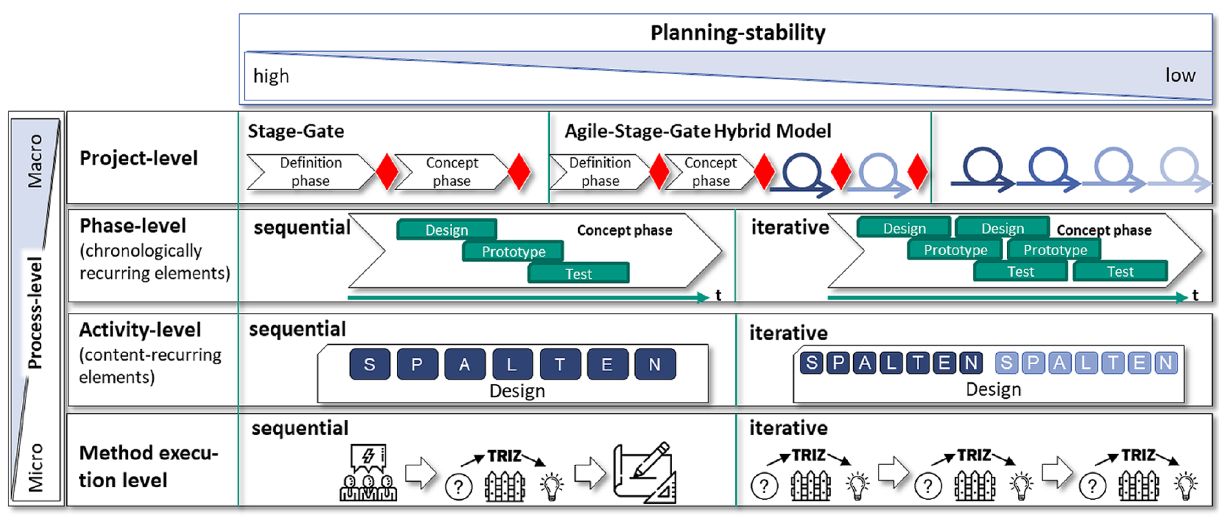
Fig. 1 Systematic for the implementation of a situation- and demand-oriented degree of agility at different process levels depending on planning stability according to